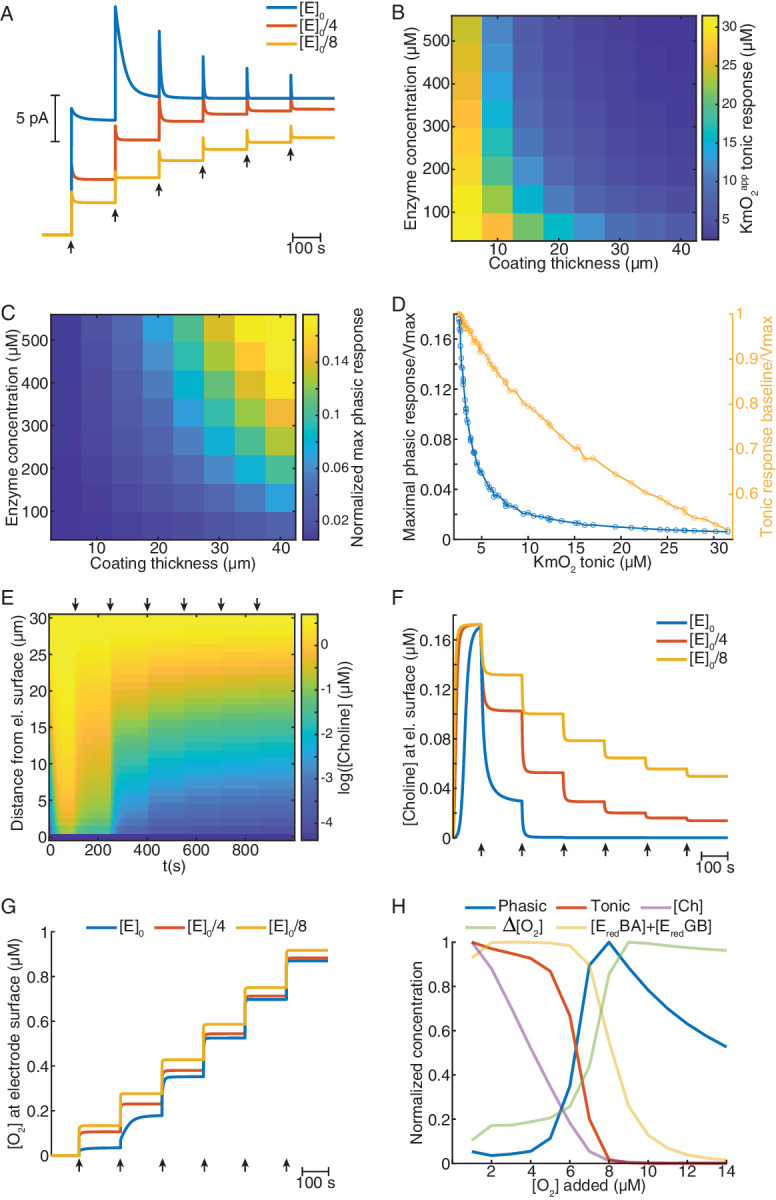
Mathematical model explains ChOx-based biosensor COA responses to oxygen.(A) Simulated calibrations of biosensors with different enzyme concentrations in the coating (coating thickness of 30 μm). Choline in bulk solution was kept constant at 5 μM and O2 was incremented in 5 μM steps from zero to 30 μM (arrows). (B) KmO2app of tonic responses as a function of coating thickness and enzyme concentration in the coating. (C) Normalized maximal phasic responses of sensors with different coating thicknesses and enzyme concentrations. Magnitudes refer to the highest phasic response divided by the maximal cumulative tonic response (Imax) from the respective simulated sensor calibration. (D) Blue trace represents the normalized maximal phasic response vs. tonic KmO2app and the orange trace refers to the level of saturation of the sensor's tonic response at which the maximal phasic peak occurs. Data were obtained from all combinations of coating thickness and enzyme concentration in B and C. (E) Concentration dynamics of Ch in the sensor coating as a function of distance from the electrode surface during a simulated calibration of a high enzyme-loaded sensor (coating thickness of 30 μm and enzyme concentration of 560 μM, same as the blue in A). Arrows indicate 5 μM O2 step increments in solution. (F) and (G) show time-courses of Ch and O2 concentration, respectively, at the electrode surface of sensors with different enzyme concentrations during simulated calibrations. Arrows indicate 5 μM O2 increments in solution. (H) Normalized profiles of phasic and tonic sensor responses as well as of concentrations of enzyme substrates and total reduced enzyme-bound complexes at the electrode surface as a function of O2 in solution. Data are from a simulated calibration of a sensor with a 30 μm coating and an enzyme concentration of 560 μM, upon 1 μM O2 step increases in solution. The ΔO2 is the initial rise in O2 following each O2 increment in solution (at a lag of 0.3 s).